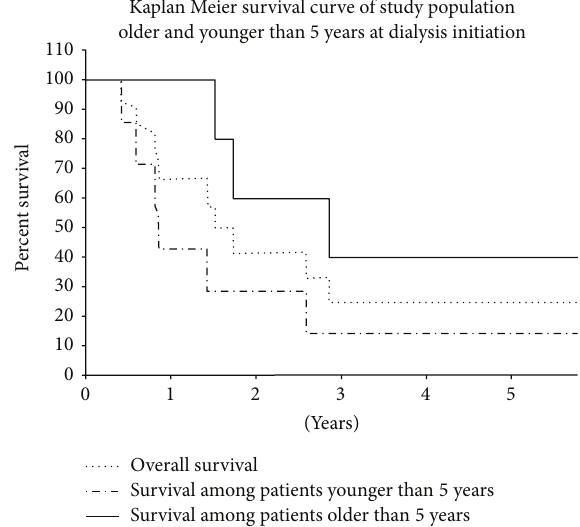
Figure 1: Kaplan Meier survival curve of study population and Kaplan Meier survival curves of children beginning dialysis at age > 5 years or < 5